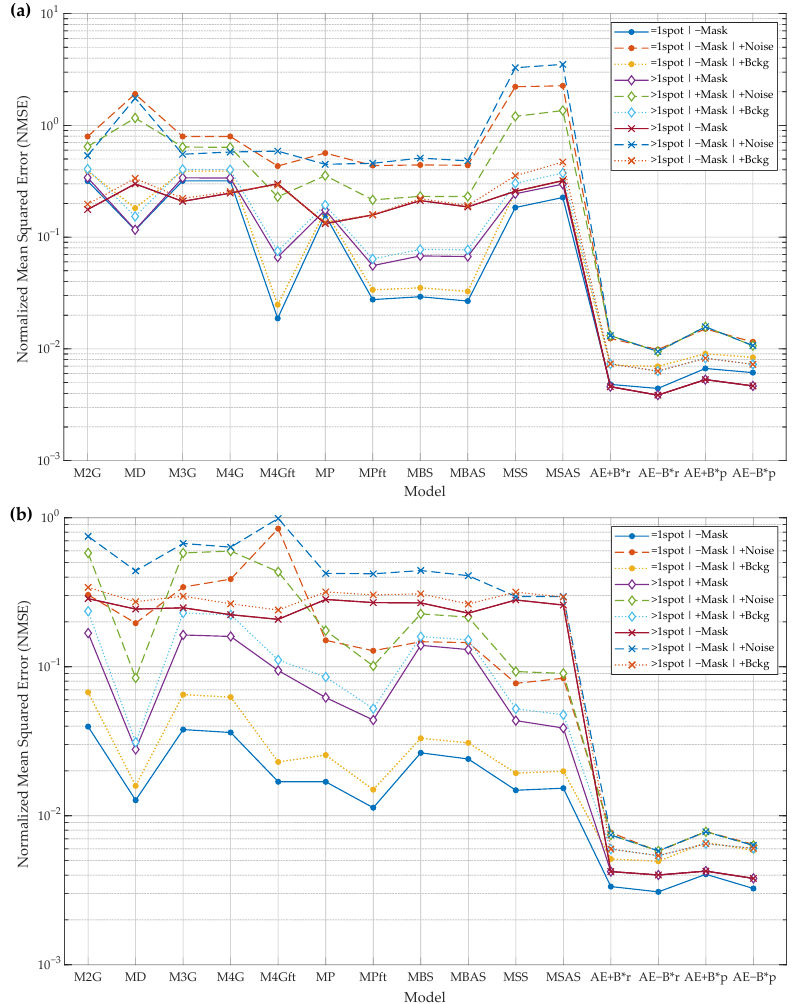
Figure 9. Results of protein spot key parameter estimation: peak intensity ( a ) and integrated spot intensity (volume) ( b ). Model performance is compared by normalized mean of squared error (NSSE) (lower is better). Models “M2G”–“MSAS” are the baselines, and “AE+B*r”, “AE − B*r”, “AE+B*p”, and “AE − B*p” are the developed autoencoder-based spot models. Experimental cases: “=1spot”/“>1spot”—one or more spots in the input image; “+Mask”/“ − Mask”—spot mask is pro- vided or not (mask is used by the baseline algorithms); “+Noise”/“+Bckg”—input images may be corrupted by Gaussian noise or by slowly varying background. Please refer to the text of Section 3 for more details on the models and for the description of the experimental case notation used in the